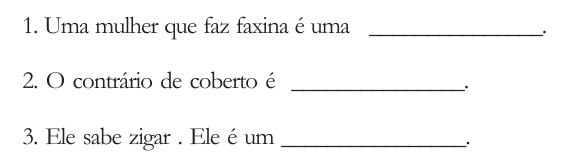
Figura 3. Exemplo de itens da tarefa de completamento de sentença.